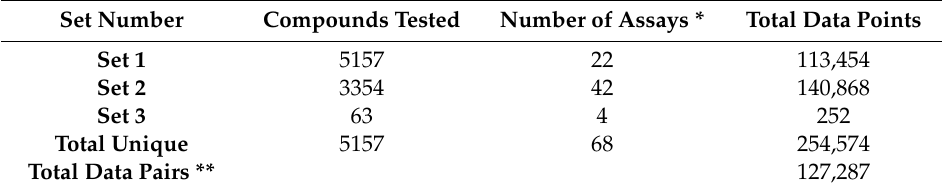
Table 1. Data Matrix Statistics .